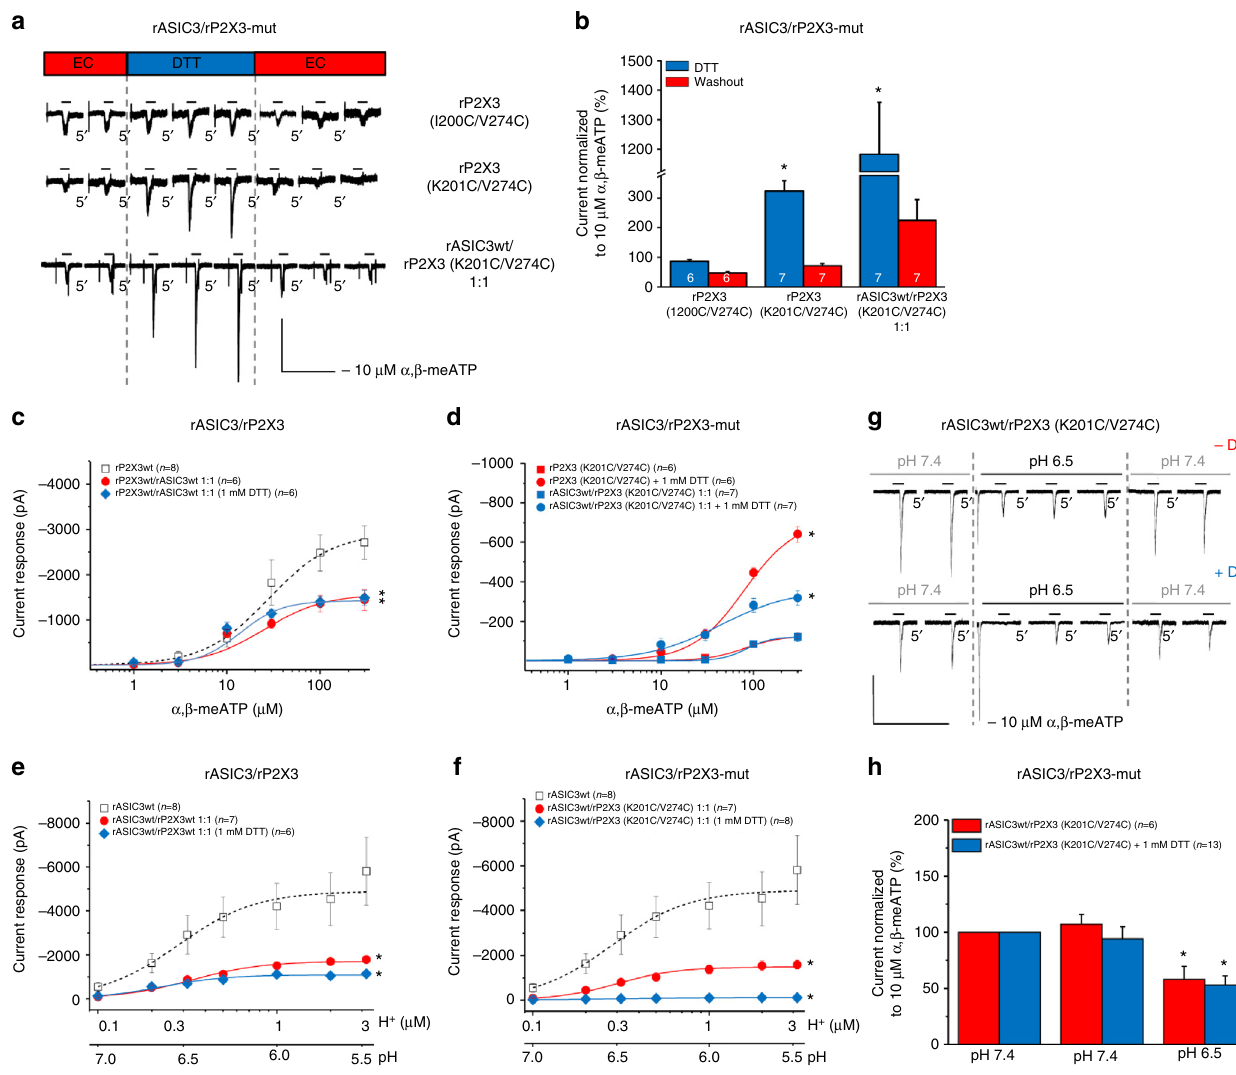
Fig. 6 Effects of gate-inhibitory mutations in rP2X3Rs on rASIC3/rP2X3R function. Whole-cell patch-clamp recordings at a holding potential of − 65 mV. a , b Analysis of rP2X3 double cysteine mutants with disul fi de trapping. CHO cells were transfected with the cysteine mutants rP2X3 (I200C/V274C), rP2X3 (K201C/V274C) or co-transfected with rASIC3wt and rP2X3 (K201C/V274C) in a 1:1 ratio. a Current traces induced by α , β -meATP (10 µ M) applied repeatedly for 2 s with 5 min intervals before, during and after the co-application of ditiothreitol (DTT; 1 mM). b Percentage changes of α , β -meATP-induced current responses were calculated with respect to the mean of the second and third currents during DTT application. Means ± S.E.M. of the indicated number of experiments. * P < 0.05; statistically signi fi cant difference between the current amplitudes during and after DTT application (Student ’ s t -test). c – f Concentration – response curves for protons and α , β -meATP in CHO cells co-transfected with the indicated receptors. c Effect of α , β -meATP (0.3 – 300 µ M) on rP2X3Rwt, and rASIC3wt/rP2X3Rwt in the absence or presence of DTT. d Effect of α , β -meATP on rP2X3R (K201C/V274C) and rASIC3/rP2X3R (K201C/V274C) in the absence or presence of DTT. e Effect of protons (pH 7.0 – 5.5) on rASIC3wt and rASIC3wt/rP2X3Rwt in the absence or presence of DTT. f Effect of protons (pH 7.0 – 5.5) on rASIC3wt and rASIC3wt/rP2X3R (K201C/V274C) in the absence or presence of DTT. Means ± S.E.M. of the indicated number of experiments. * P < 0.05; statistically signi fi cant difference of the I mean values at the highest agonist concentration from the rP2X3Rwt and rASIC3wt curves, respectively (one-way ANOVA followed by the Holm – Sidak test). g Interaction between rASIC3wt and rP2X3R (K201C/V274C) in the absence and presence of DTT. Currents were elicited by α , β -meATP (10 µ M) for 2 s with 5 min intervals before, during and after the pH shift from 7.4 to 6.5. h Percentage changes of α , β -meATP-induced current responses were calculated with respect to the second current before the pH shift. Means ± S.E. M. of the indicated number of experiments. * P < 0.05; statistically signi fi cant difference between the current amplitudes before and after the pH shift from 7.4 to 6.5 (Student ’ s t -test). The scale labels for the vertical bars were 200 pA ( a , g ). The scale labels for the horizontal bars were 20 s ( a ) and 50 s ( g